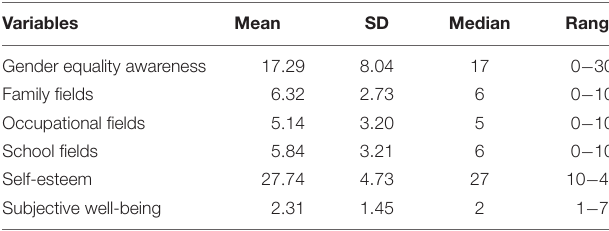
TABLE 2 | Descriptive statistics of the measured variables ( N = 284).